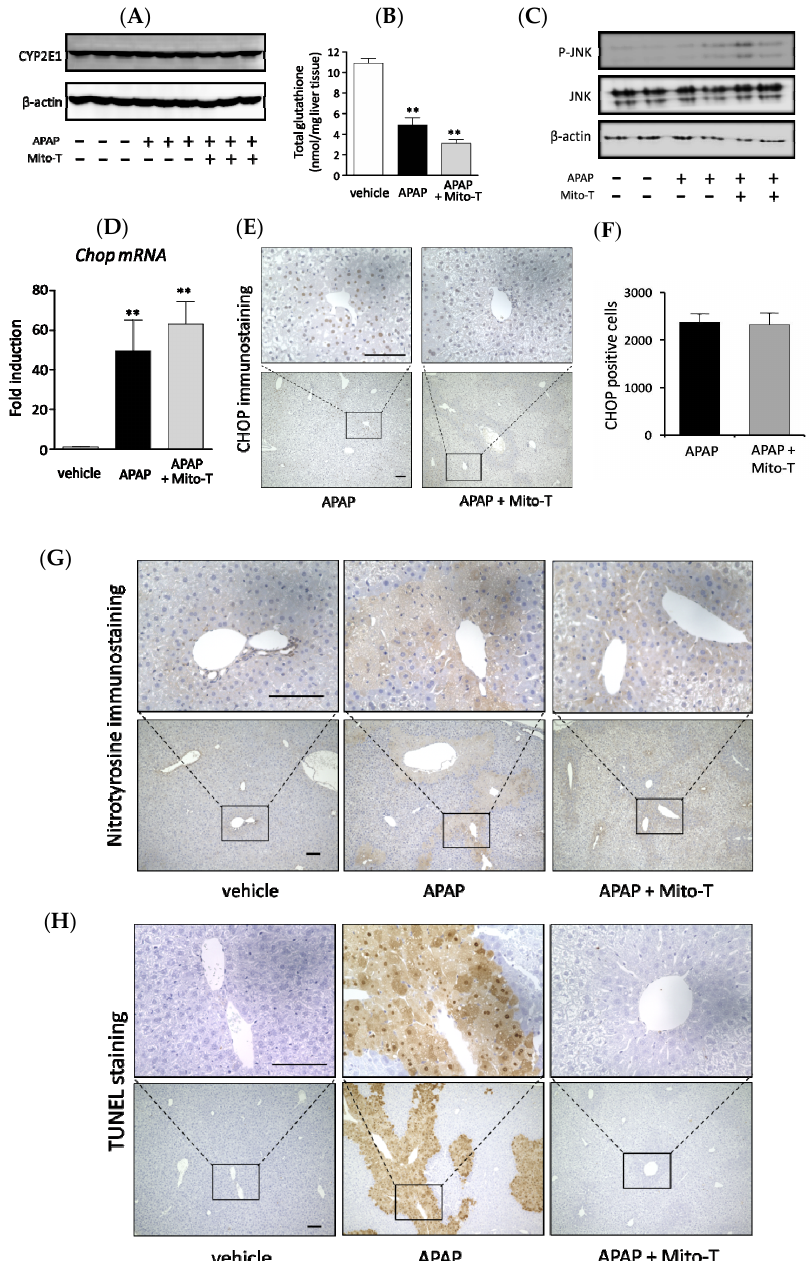
Figure 2. E ff ect of Mito-T on APAP liver injury pathophysiology. Mice were treated with APAP (400 mg / kg, i.p.) and 1 h later Mito-T (20 mg / kg, i.p.) or saline was administered. Liver tissue samples were collected from mice 4 h after APAP injection. Representative western blot of CYP2E1 expression ( A ) and total glutathione (GSH) level ( B ) in mouse liver is shown for each group. Each bar represents the mean ± SEM ( n = 3–4). ** p < 0.01 vs. the saline group. ( C ) Representative western blot of p -c-jun N-terminal kinases (JNK) and JNK expression in mouse livers 4 h after APAP administration. ( D ) Liver tissue samples were collected from mice 4 h after APAP injection. mRNA levels of Chop in mouse livers were analyzed by quantitative real-time RT-PCR. ( E ) Representative CHOP staining of mouse livers is shown. ( F ) CHOP positive cells were quantified from CHOP immunostained mouse livers. Each value represents the mean ± SEM ( n = 3–4). ** p < 0.01 vs. the saline group. ( G ) The liver samples were collected8h afterAPAPadministrationandnitrotyrosineimmunohistochemicalstainingwasperformed. ( H ) The liver samples were collected 8 h after APAP administration and terminal deoxynucleotidyl transferase-mediated dUTP nick end labeling (TUNEL) immunohistochemical staining was